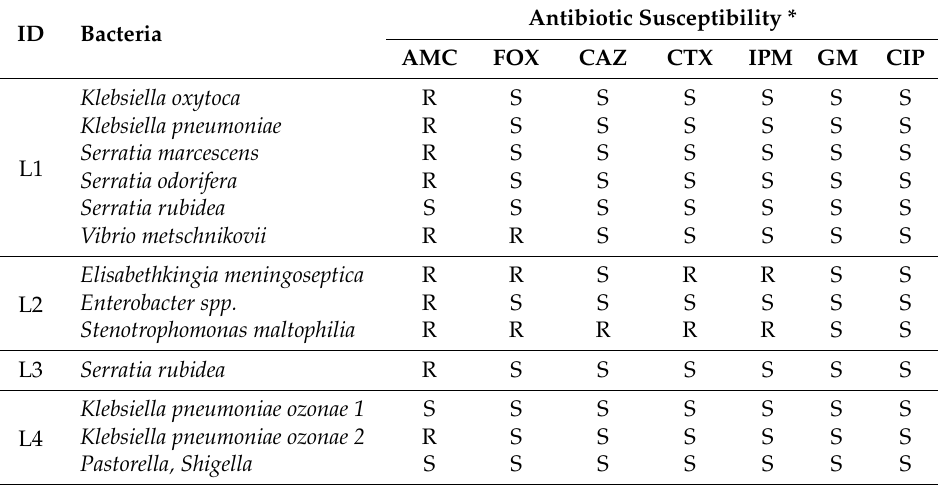
Table 1. Antibiotic susceptibility of bacterial isolates identified from water in Lake (L1 and L2) and ornamental fountains (L3 and L4) in February.